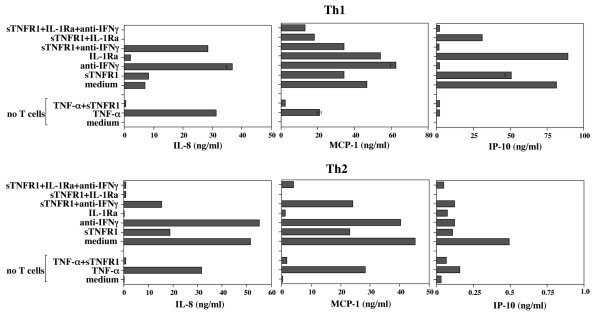
Living T-helper cells differentially induce IL-8, MCP-1, and IP-10 by fibroblasts cultured in transwell chambers. Fibroblasts were plated at 1.5 × 104 cells in the upper transwell chamber; 72 hours later the culture medium was replaced and T cells (1 × 106) were plated in the lower transwell chamber previously coated with anti-CD3 mAb. Chemokine levels were determined by enzyme-linked immunosorbent assay in 48-hour supernatants. TNF-α (100 ng/ml) was used as a positive control in wells without T cells. Anti-TNF (soluble TNF receptor I; 10-8 mol/l), IL-1 receptor antagonist (2 μg/ml) and anti-IFN-γ (10 μg/ml), alone or in combination, were added to the lower wells 30 minutes before T cells. The bars represent the mean of duplicate wells. Note that the scale is different in each panel and for IP-10 it is 100 times smaller for Th2 than for Th1 cells. Similar results were obtained in an additional experiment. IFN, interferon; IL, interleukin; IP, interferon-γ inducible protein; MCP, monocyte chemoattractant protein; Th, T-helper; TNF, tumour necrosis factor.